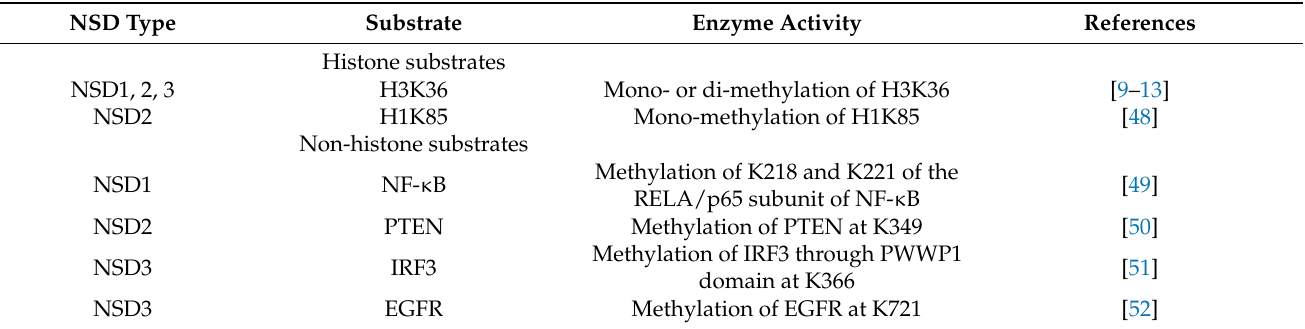
Table 1. Histone and non-histone substrates of the NSDs.